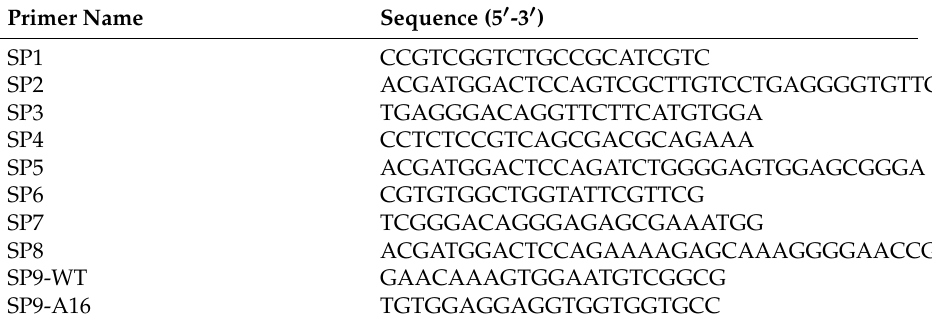
Table 1. Specific nested-primers for PpDXS1 promoter